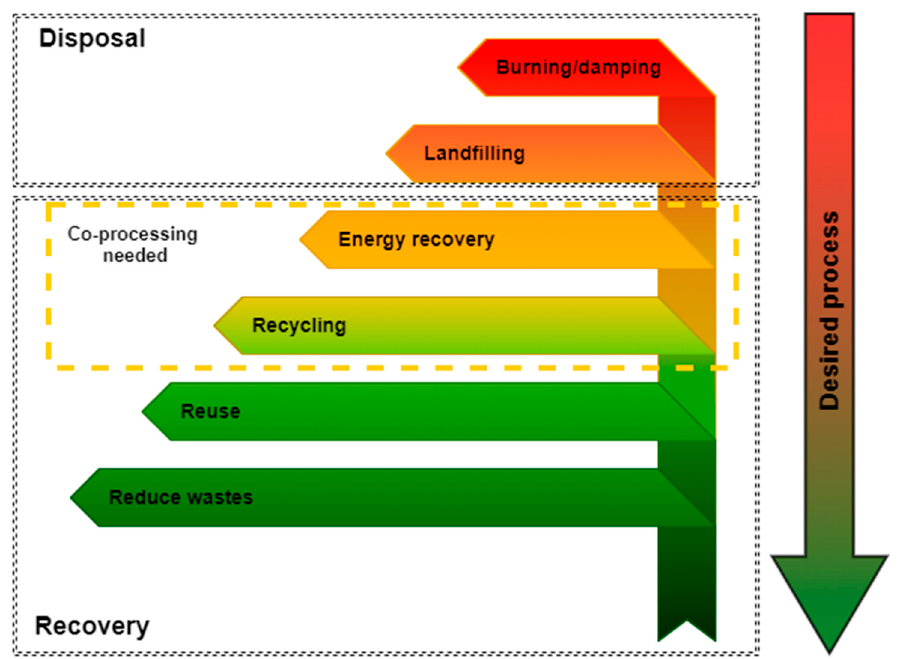
Figure 1. Polymers waste end-of-life (EoL) options based on the EU Waste Framework Directive.